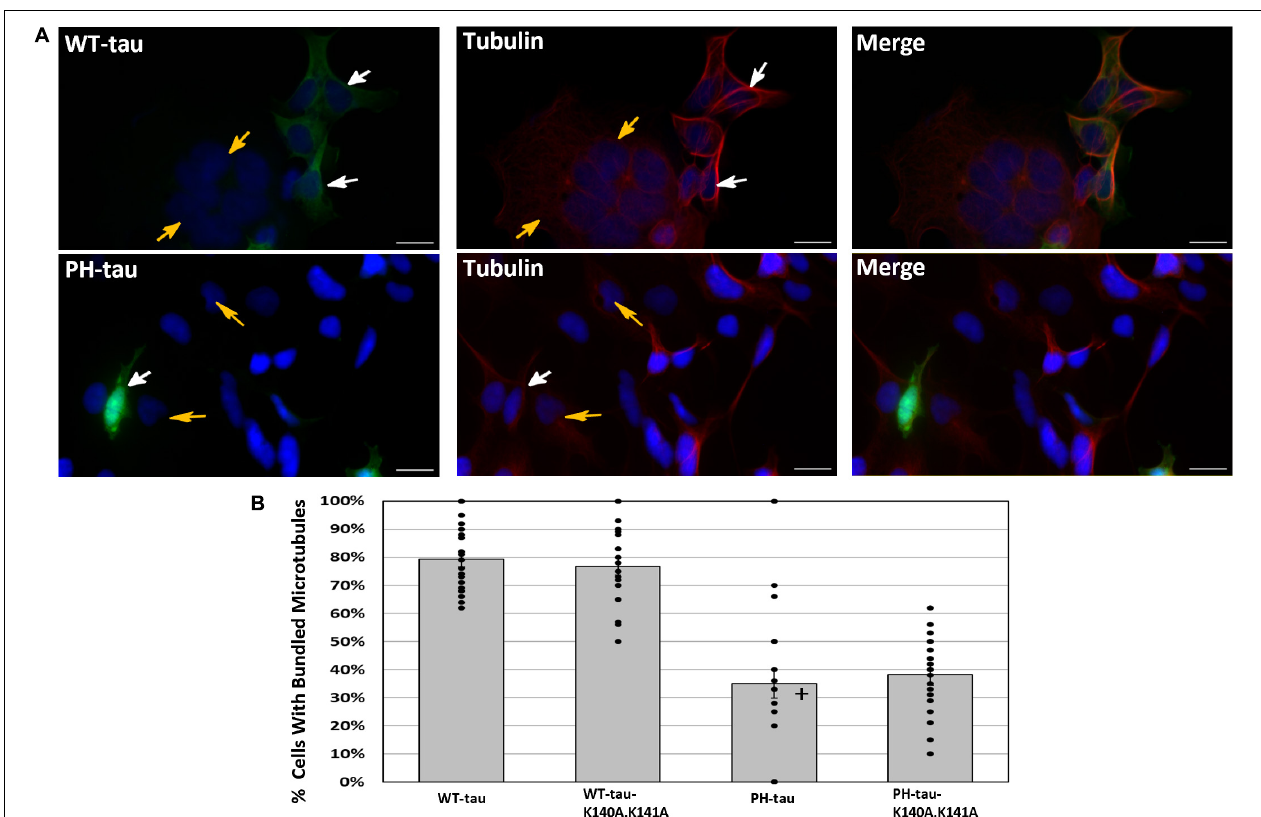
FIGURE 2 | Microtubule bundling occurs in the presence of WT-tau but not PH-tau in a manner independent of its nuclear localization. (A) HEK-293 cells were transfected with WT-tau, PH-tau, WT-tau-K140A,K141A, or PH-tau-K140A,K141A and immunostained for α -tubulin. Microtubule bundling induced by WT-tau was determined by observation of a ring-like structure around the periphery of the cell. The top set shows the staining in WT-tau-transfected cells, and the bottom set of images shows the staining in PH-tau-transfected cells. The images demonstrate the presence of this structure in WT-tau-positive cells (white arrows, top), but not in tau-negative cells (gold arrows, top and bottom) or PH-tau-positive cells (white arrows, bottom). Scale bar indicates 30 µ m. (B) The number of tau-positive cells in each group that displayed the indicated microtubule structure was counted and expressed as a percentage of all tau-positive cells. The mean percentage across all images ( n = 20) was plotted as a bar graph. Error bars indicate SEM. The bars are overlayed with a dot plot of the percentages calculated from individual images ( n = 20). Data were analyzed using Welch’s ANOVA, and Games-Howell post-hoc test was used for pairwise comparisons. A + indicates a significant difference from WT-tau ( p = 0.013 vs. PH-tau; p = 0.001 vs. PH-tau-K140A,K141A) and from WT-tau-K140A,K141A ( p = 0.001 vs. PH-tau; p = 0.031 vs.